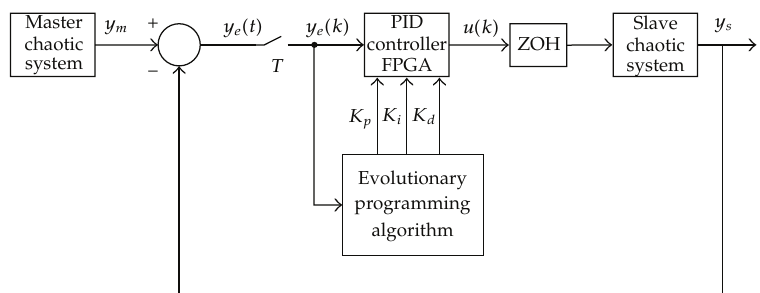
Figure 1: Block diagram of chaos synchronization